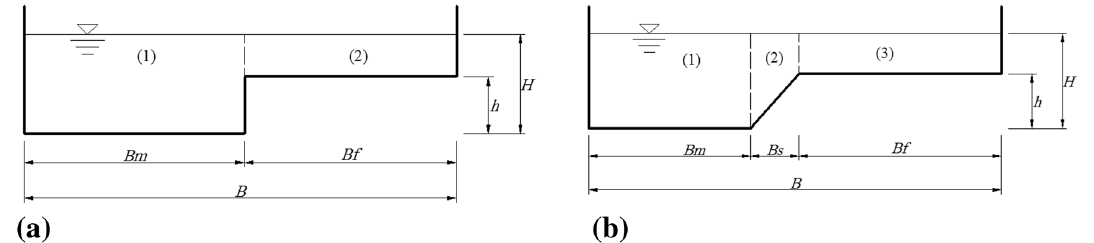
Table 1 Geometrical and hydraulic parameters for experimental compound channels considered Parameter SRC-1 Flow depth ( H ), cm